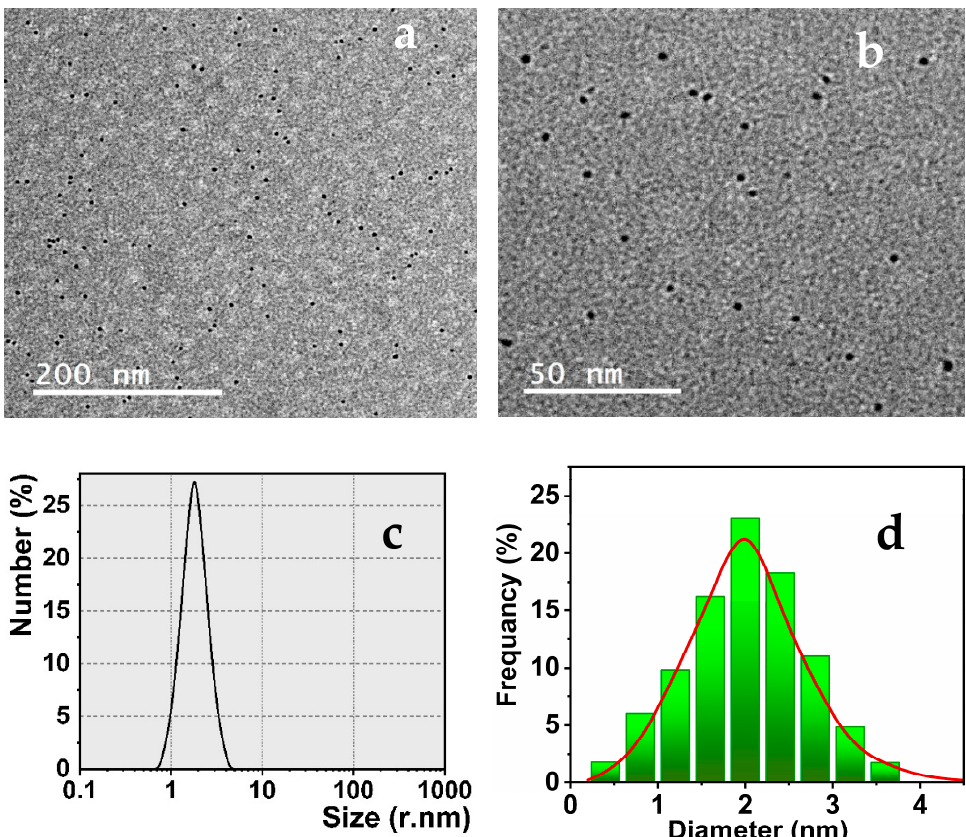
Figure 2. ( a , b ) TEM images; ( c ) DLS; and ( d ) SD histogram of the as-prepared Tryp-AgNCs.